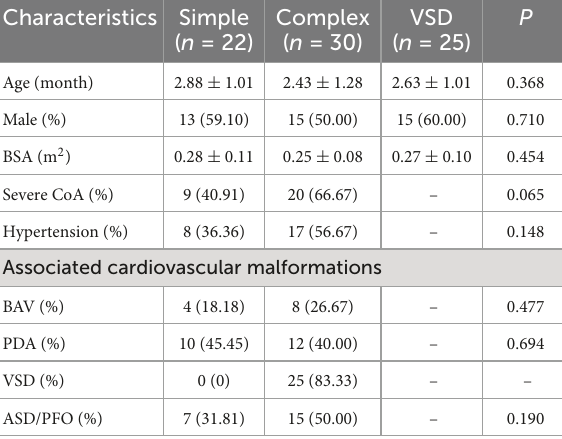
TABLE 1 General characteristics of the population. TABLE 2 Comparison of aortic dilatation and arch hypoplasia